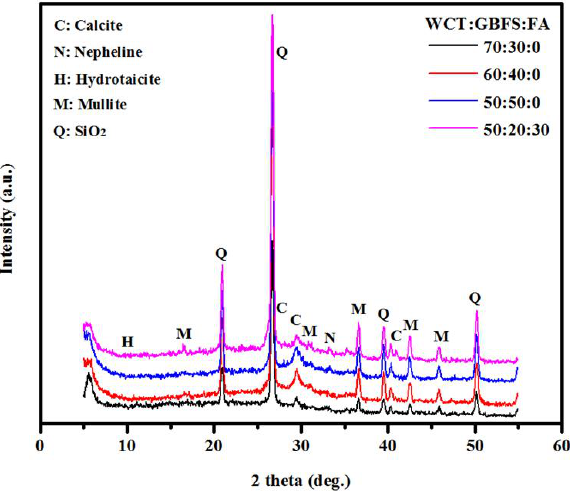
Figure 3. Effects of various WCT:GBFS:FA on the XRD patterns of GPMs.